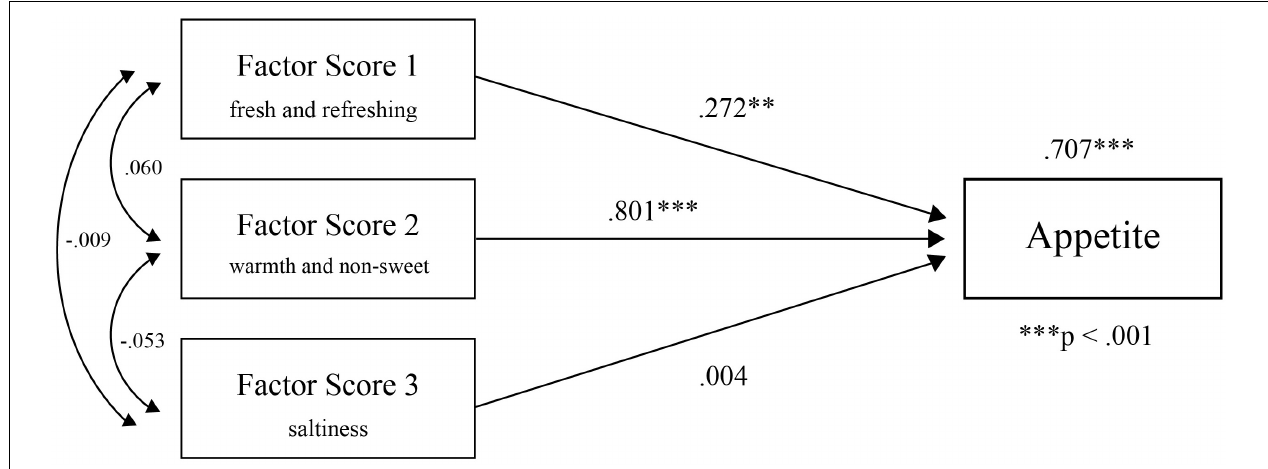
FIGURE 2 | Factor 2 has more influence than Factor 1 on appetite from the high correlation coefficient scores. We named Factor 1 the “fresh and refreshing factor.” Factor 2 was the “warm and non-sweet factor,” and Factor 3 was the “saltiness factor.” ** and *** denotes P < 0.01 and P < 0.001, respectively.